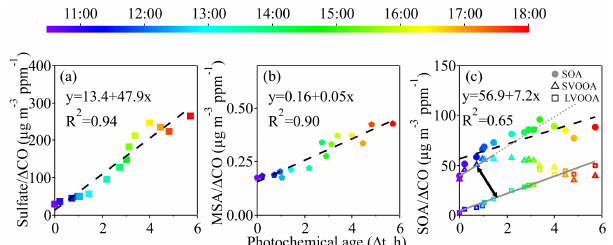
Figure 10. Photochemical production of secondary species. (a) CO- normalized sulfate concentration (sulfate /(cid:49) CO) as a function of photochemical age, (b) CO-normalized MSA concentration (MSA /(cid:49) CO) as a function of photochemical age, and (c) CO- normalized secondary organic aerosol concentration (SOA /(cid:49) CO, SOA(SVOOA + LVOOA)) as a function of photochemical age. Data points are colored according to time of day. Data points repre- sent half-hour